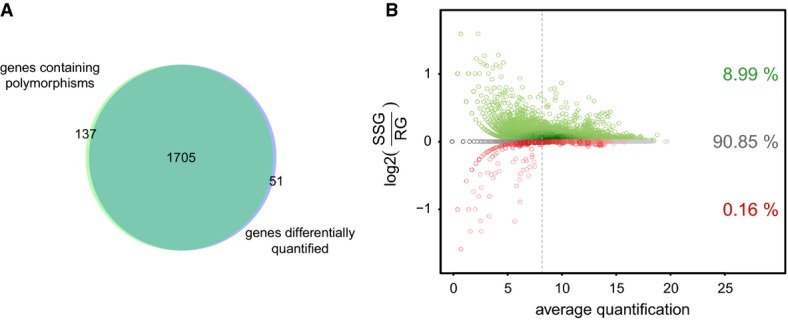
Accounting for individual genomes affects expression quantificationVenn diagram showing the overlap between genes with at least one polymorphism and genes
differentially quantified in at least one sample when mapping against the strain-specific genome
(SSG) as compared to mapping against the reference genome (RG).Comparison of expression quantification measurements obtained by the SSG and RG mapping
strategies. Green (red): measurements quantified higher (lower) using SSG versus RG. Color
intensities reflect the density of points. The vertical line denotes the median gene expression.